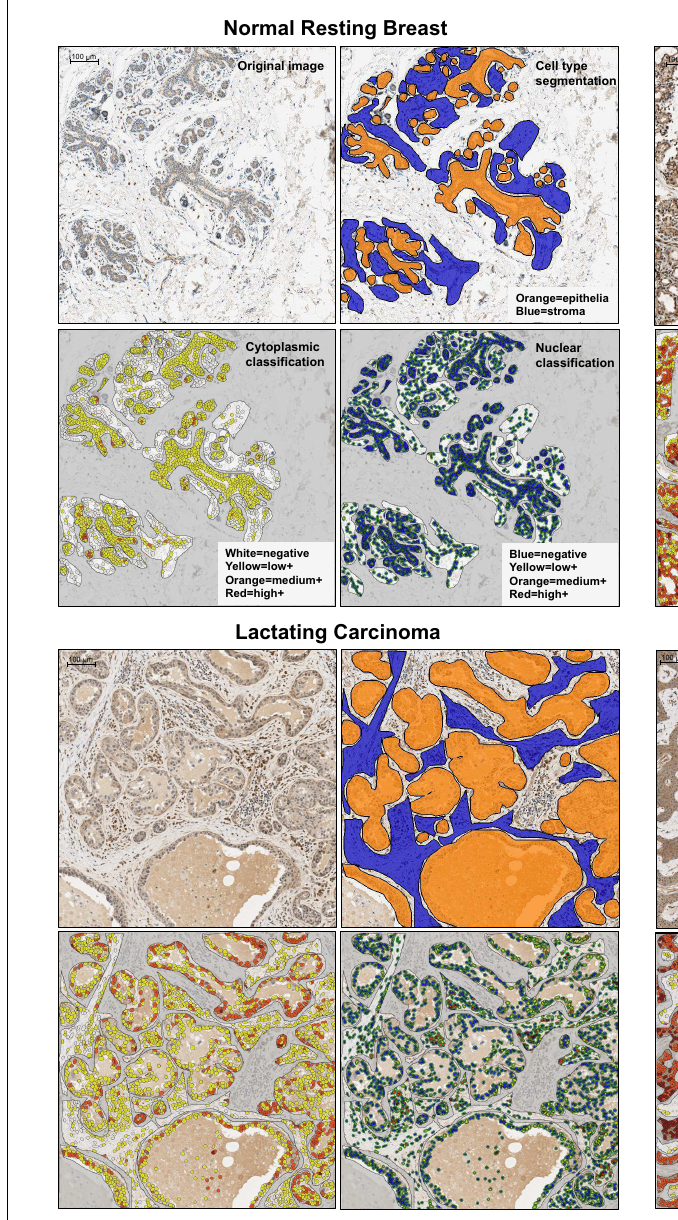
stromal regions; the bottom left panel shows the cytoplasmic classification, with white: negative cytoplasm, yellow: low positive cytoplasm, orange: medium positive cytoplasm, red: highly positive cytoplasm; the bottom right panel shows the nuclear classification, with blue: negative nucleus, yellow: low positive nucleus, orange: medium positive nucleus, red: highly positive nucleus. PABC: pregnancy-associated breast cancer. Scale bars: 100 µ